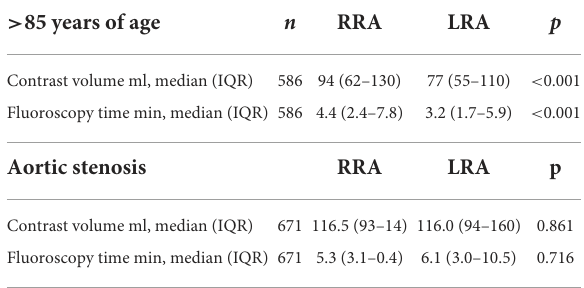
TABLE 3 Contrast volume and fluoroscopy times *